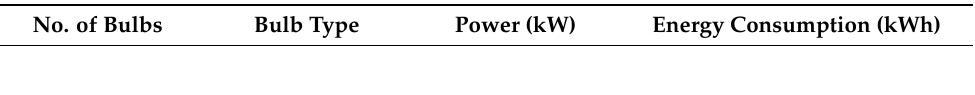
Table A2. Data requested for public lighting.